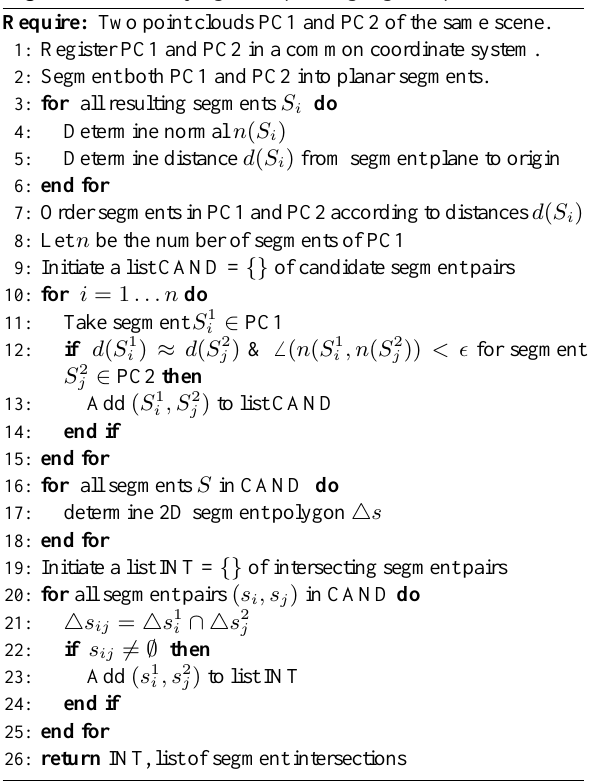
Algorithm 1 Identifying corresponding segment parts